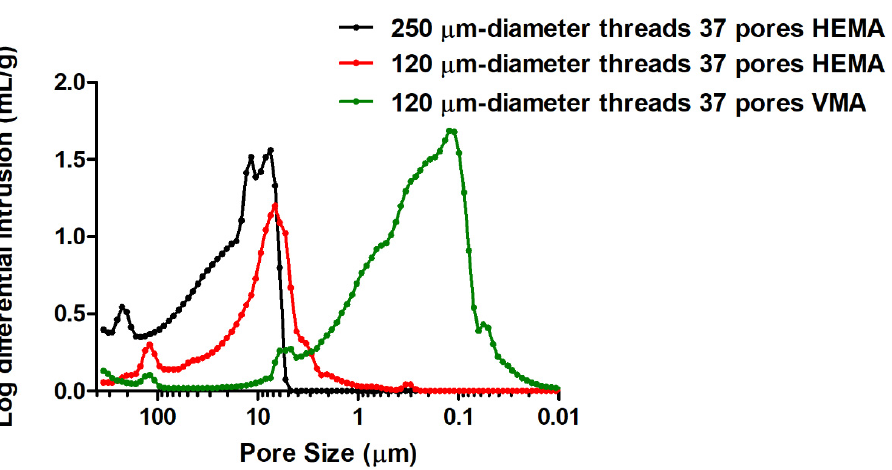
Figure 6. MIP profile of HEMA or VMA-based biporous materials with tubular macropores (thread diameters used: 120 and 250 µm). The polymerization mixture was constituted of 70/30 mol.% HEMA or VMA/EGDMA and 80 vol.% i -PrOH or EtOAc with respect to the total volume of comon- omers.